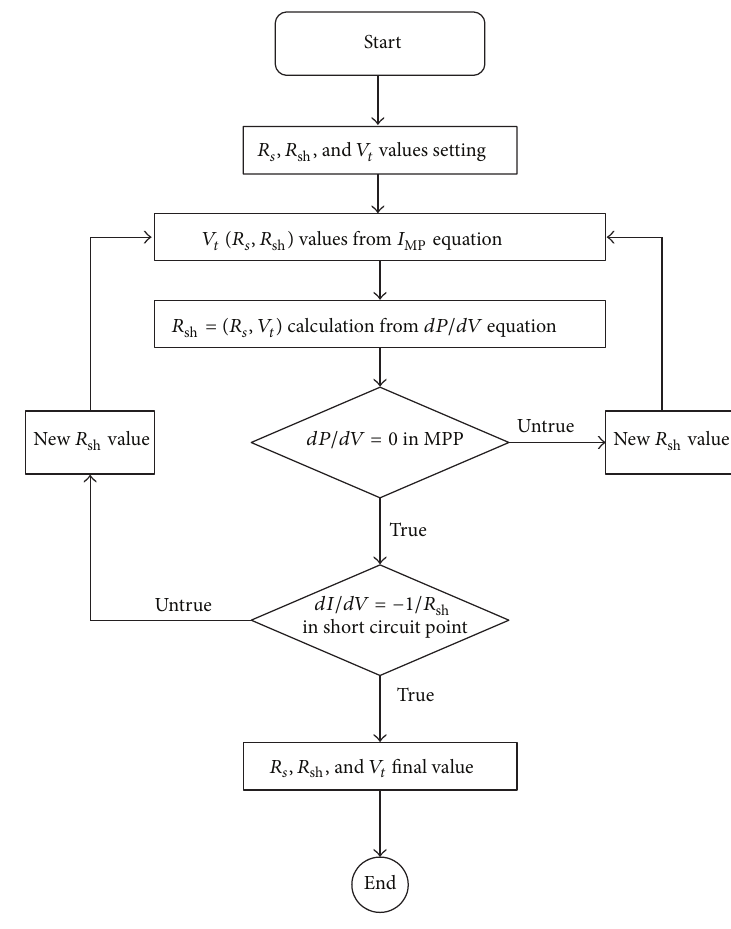
Figure 4: Determination of 𝑅 𝑠 , 𝑅